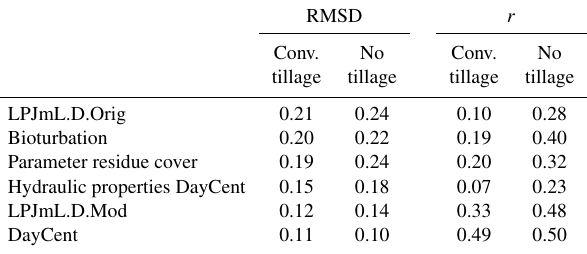
Table 4. Performance of DayCent and LPJmL compared to ob- served soil moisture (fraction of the WFPS) in Nebraska. The re- sults are shown for both conventional tillage and